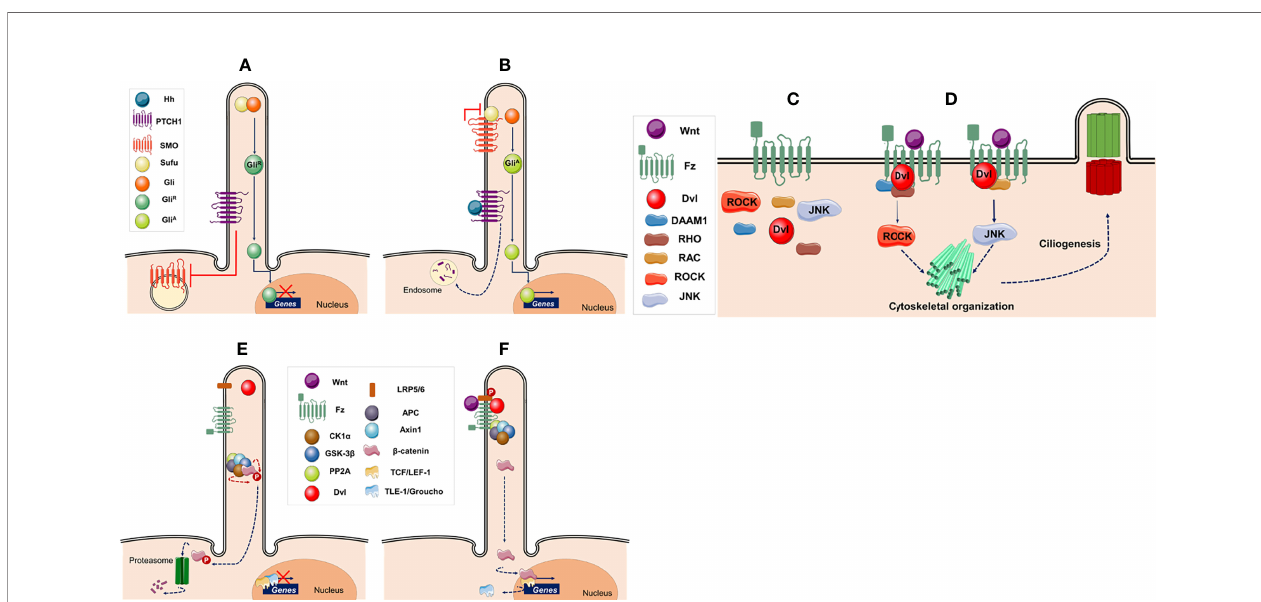
FIGURE 2 | Ciliary signaling pathways. (A – B) Hedgehog signaling pathway (A) In the absence of hedgehog (Hh) ligand the intra fl agellar transport machinery moves the transcription factor glioma-associated oncogene (GLI) and suppressor offused (SuFu) to the ciliary tip. Patched-1 (PTCH1) located in the surface of the ciliary membrane inhibits Smoothened (SMO), which is located in the cytoplasm, keeping GLI in an inactive form (GLI R ). The inactive transcription factor is transported back to the cell body and enters the nucleus where represses the expression of genes such as CCND1 , N-MYC , G LI1 , GLI2 , and PATCH1 . (B) Binding of ligand (Hh) to PTCH1 leads to the formation of oligomers, which are degraded in endosomes, reliving the repression of SMO, and causing its re-localization to the ciliary tip. SMO interacts with SuFu leading to the maturation of GLI into its active form (GLI A ). GLI A is transported back to the cell body and enters the nucleus where activates transcription of target genes. (C, D ) Canonical Wnt signaling pathway. (C) Without Wnt ligands, b -catenin is ubiquitinated and degraded by the proteasome. The initial events of this pathway are regulated by a destruction complex composed of casein kinase 1 a (CK1 a ), glycogen synthase kinase 3 b (GSK-3 b ), protein phosphatase 2A (PP2A), adenomatous polyposis coli (APC), and Axin 1. In the absence of b -catenin, the nuclear T cell-speci fi c transcription factor/lymphoid enhancer factor-1 (TCF/LEF-1)-responsive elements are associated with transcriptional suppressors, such as Groucho (Gro) and Transducin-like enhancer of split-1 (TLE-1), keeping the pathway inactive. (D) When Wnt ligands bind the Frizzled (Fz) family receptors and its coreceptor low density lipoprotein receptor-related protein-5/6 (LRP5/6), Fz recruits Disheveled (Dvl) to inactivate the b -catenin destruction complex. Thus, b -catenin accumulates in the cytoplasm and translocates to the nucleus where replaces Gro/TLE, and acts as a transcriptional co- activator with TCF/LEF-1, inducing transcription of Wnt target genes. (E, F) Planar cell polarity signaling pathway. (E) In the absence of Wnt ligands the pathway is inactive. (F) When a signal is received by the Fz receptor a complex of proteins, including Dvl, is recruited at the plasma membrane. Dvl activates RHO-associated coiled- coil forming kinase (ROCK) and c-Jun N-terminal kinase (JUNK) in parallel, resulting in cytoskeletal organization and regulation of ciliogenesis. This fi gure was created using Servier Medical Art (available at